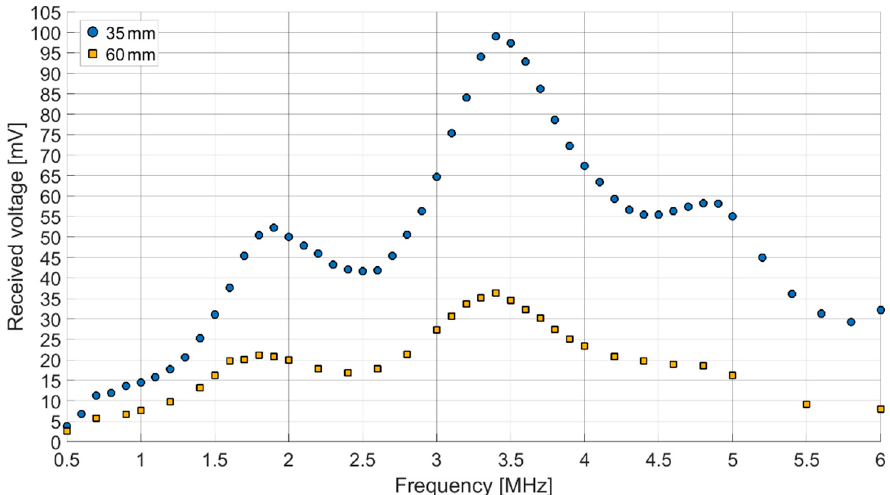
Figure 14. Receiving spectra of the ex vivo measurements, 60 V DC , 15 V AC , Burst count 20, Chip 2 (170 µm thick silicone and 25 µm thick PEEK) for transmitting, Chip 5 (50 µm thick silicone and 25 µm thick PEEK) for receiving distances of 35 mm and 60 mm.